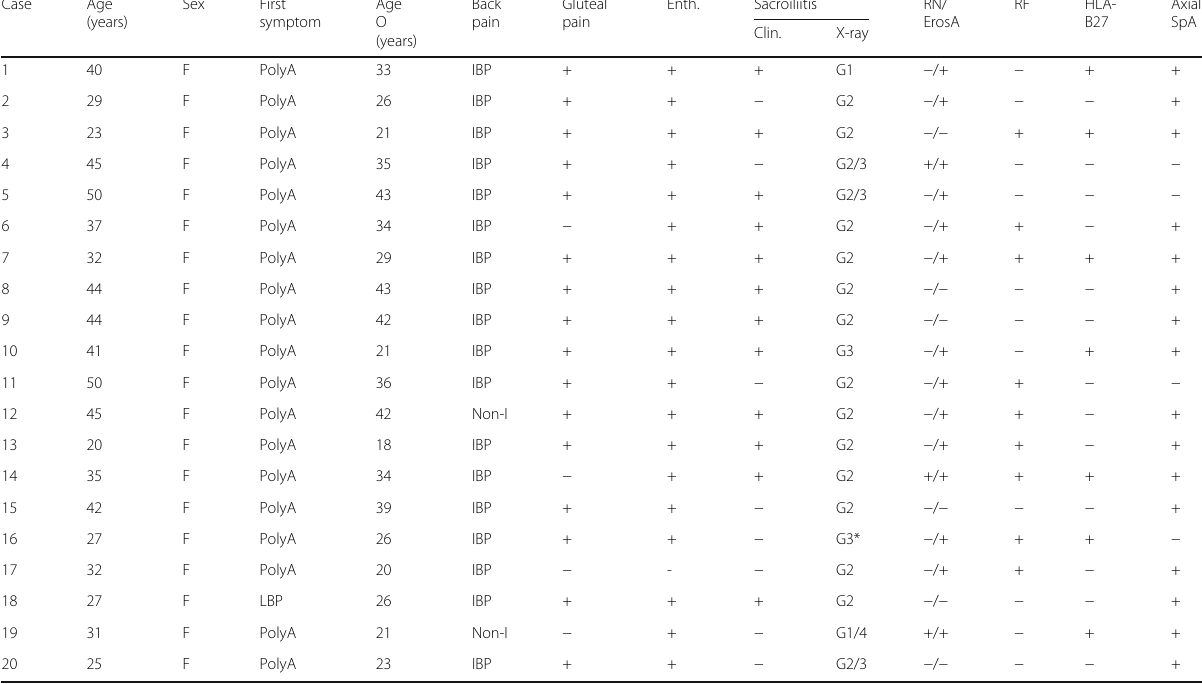
Table 2 Characteristics of rheumatoid arthritis patients with coexisting ankylosing spondylitis Case Age